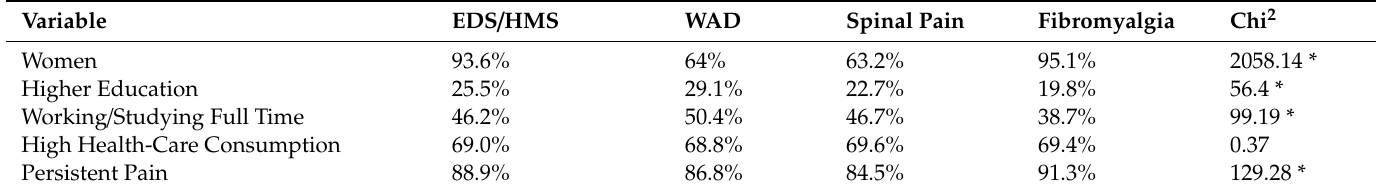
Table 3. Percentage (%) for background variables and persistent pain (i.e., the categorical variables) in the four groups of patients. Furthest to the right is reported the statistical comparison (Chi-square) between the four groups of patients.